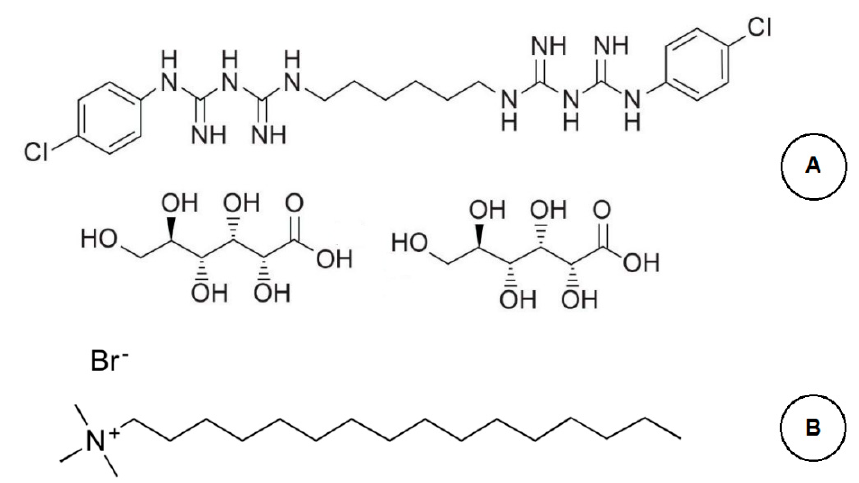
Figure 1. Molecular structures of ( A ) CHG and ( B ) CE .